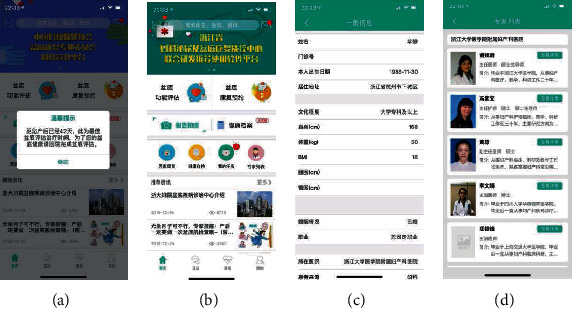
Major working interface of Penyikang: (a) alert message; (b) main interface of Penyikang; (c) individual information and questionnaires; (d) list of experts.